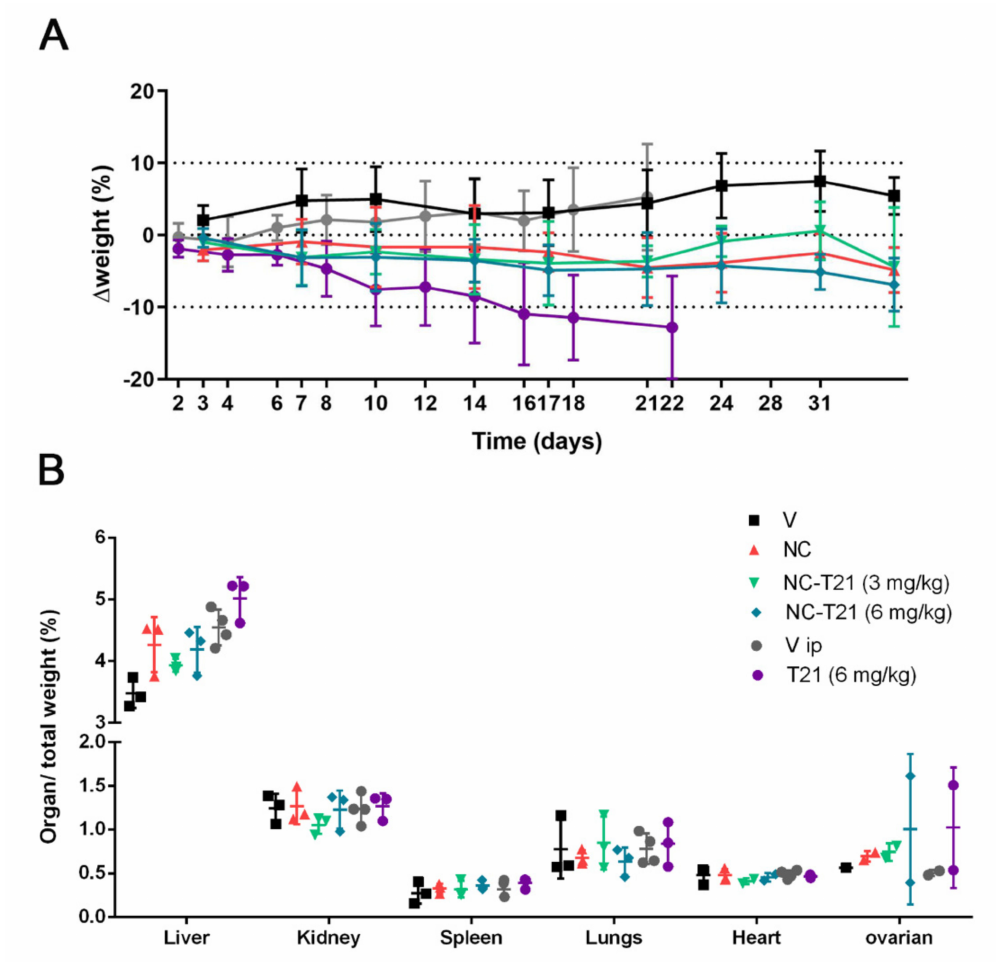
Figure 9. Effect of treatment in mouse growth and organ weight. Mice were administered i.v. with 6 mg/kg or 3 mg/kg of nanoencapsulated T21 (NC-T21), PBS (V), empty nanocapsules without T21 (NC), 6 mg/kg of free T21 (T21) administered i.p. or PBS 7.5% DMSO and 0.8% Tween (Vip). The mice received 10 i.v. doses in a twice a week regimen or every other day for i.p administration. Mouse weight was monitored during treatment; ( A ) Percentage of weight variation during treatment and ( B ) relative organs weight are